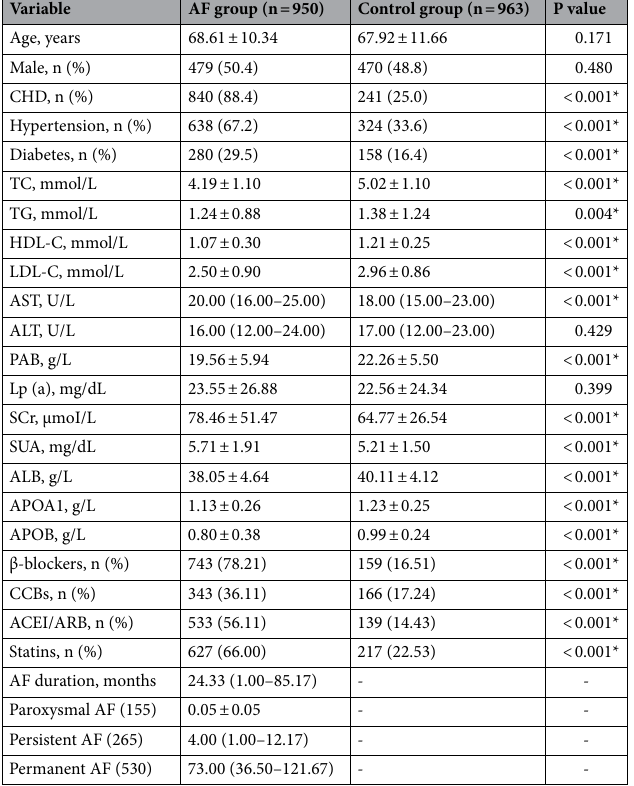
Table 1. Baseline characteristics of participants. Data were presented as mean ± SD or n (%). AF atrial fibrillation, CHD coronary heart disease, TC total cholesterol, TG triglyceride, LDL-C low-density lipoprotein